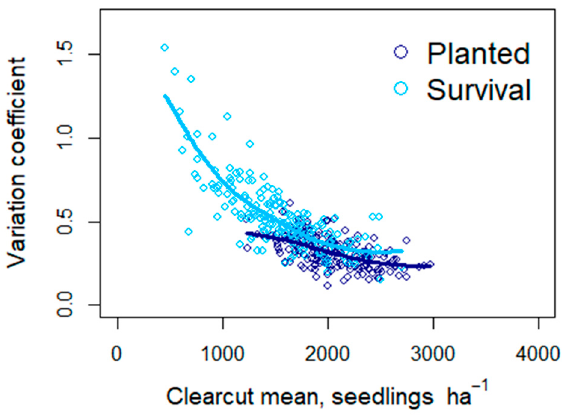
Figure 6. The variation coefficient of seedling density as a function of the clearcut mean, at the time of planting (dark blue) and three years later (light blue) and smoothed lines of the overall inventory tendencies.